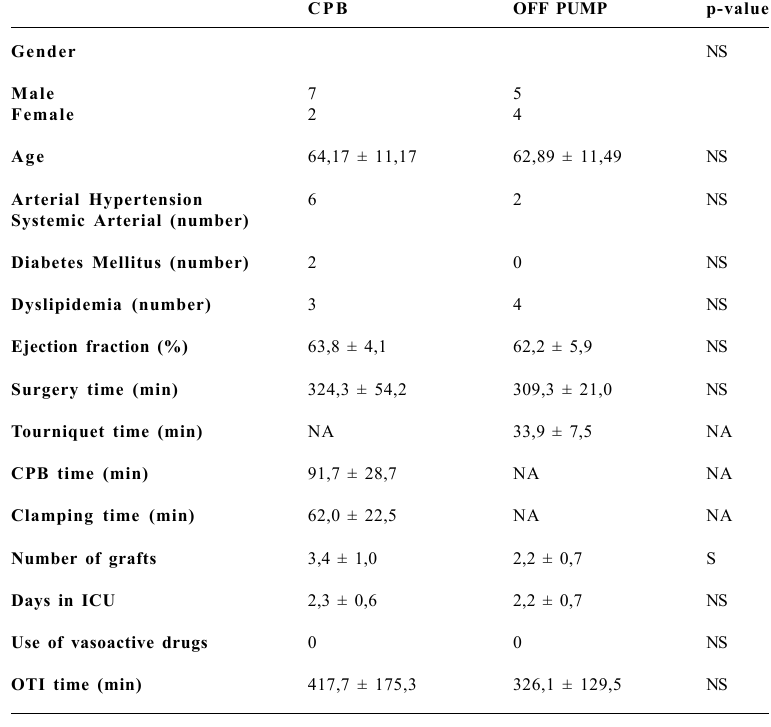
Table 1. Characteristics of the patients and operative variables for the CPB and OFF-PUMP groups (mean and standard deviation)